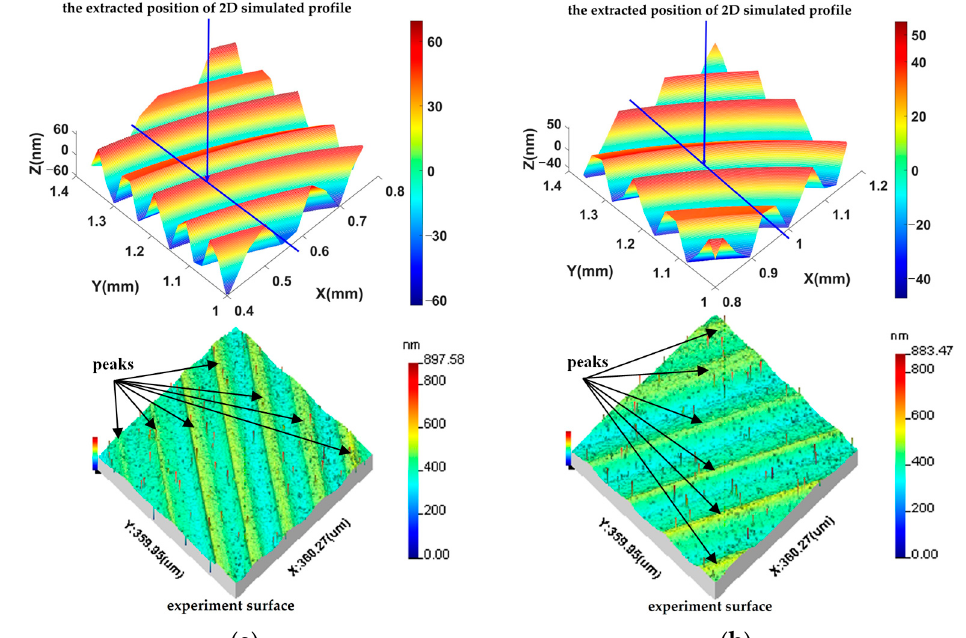
Figure 9. Comparison between the local 3D topographies of simulation results and experiment surfaces: ( a ) results for a p = 9 µ m, n = 1300 r/min, and f = 12 µ m/r; ( b ) results with a p = 6 µ m, n = 1400 r/min, and f = 14 µ m/r.